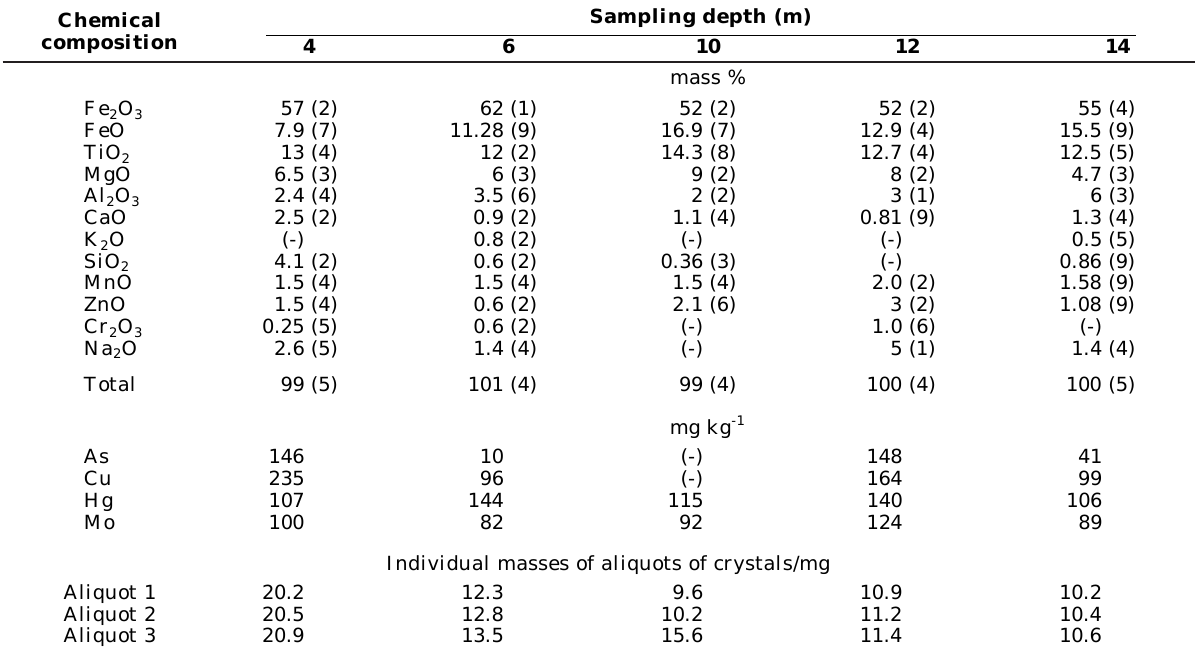
(-) means that any eventual presence of the element in the sample is in a content below the detection limit of the corresponding method of chemical analysis.